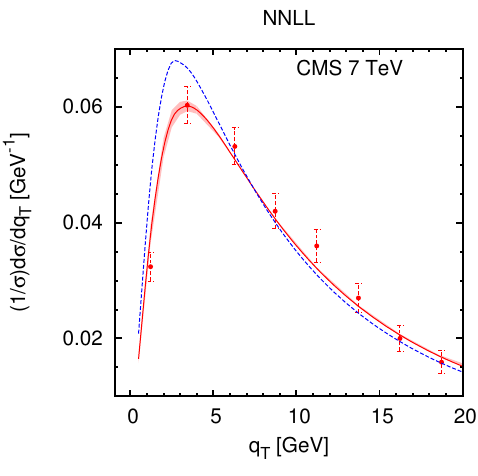
Figure 2. The red solid curve is our prediction for (1 /σ ) d σ/ dq T based on the global fit with D NP = 0 (Eq. (8)), Q i = Q 0 + q T , at NNLL-NNLO accuracy compared to CMS experimental data [32]. The band comes from the statistical error on the fit- ted parameter λ 1 . The blue dashed line is the full resummed re- sult at NNLL-NNLO accuracy with no non-perturbative input, = λ = λ 1 2